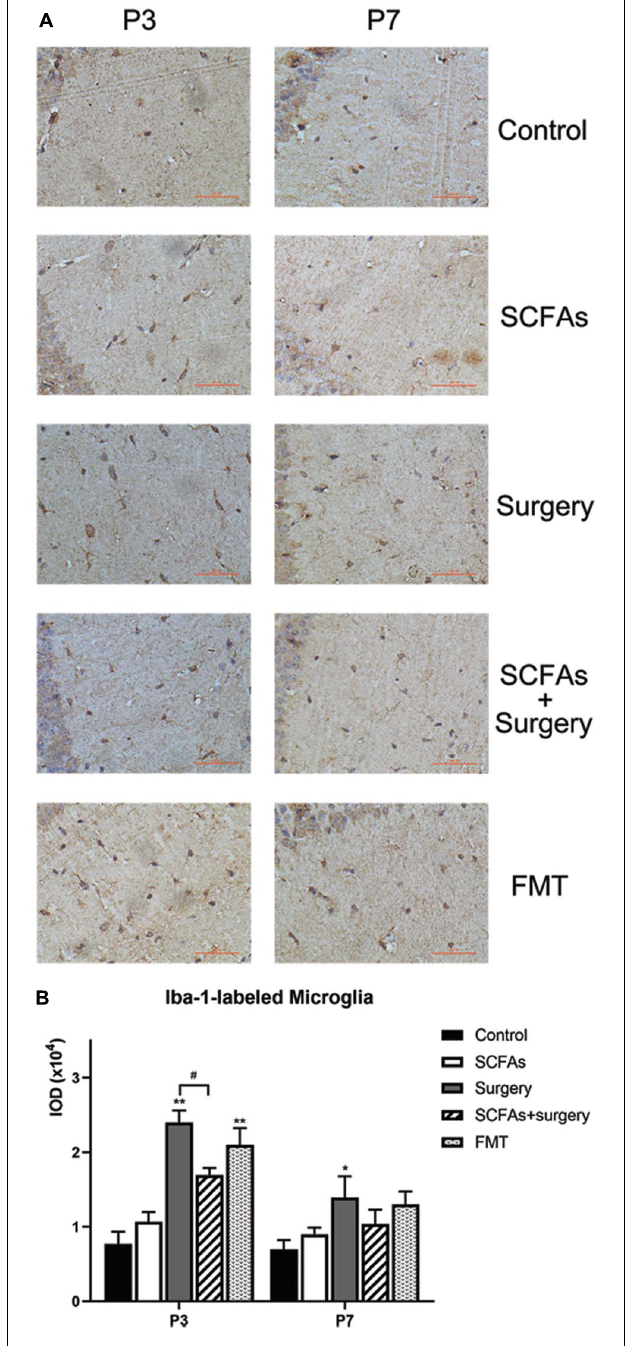
FIGURE 7 | A significant difference for hippocampal Iba-1 levels was observed between control and surgical mice. Surgical trauma, anesthesia, and fecal microbiota transplantation enhanced Iba-1 expression and SCFA pretreatment partially reversed this change on postoperative day 3. (A) Representative images of Iba-1-labeled activated microglia in the hippocampus. (B) The IOD of Iba-1 in the hippocampus. The results are represented as mean ± SEM. * p < 0.05 vs. the day-matched control group, ** p < 0.001 vs. the day-matched control group, # p < 0.05 vs. the day-matched surgery group. P3 and P7: postoperative or post-transplantation days 3 and 7, respectively. Scale bars: 200